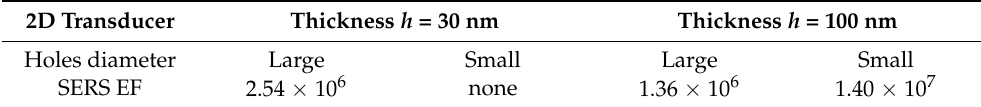
Table 1. Summary of SERS results (enhancement factor EF) for the investigated nanostructures. 2D Transducer Holes diameter